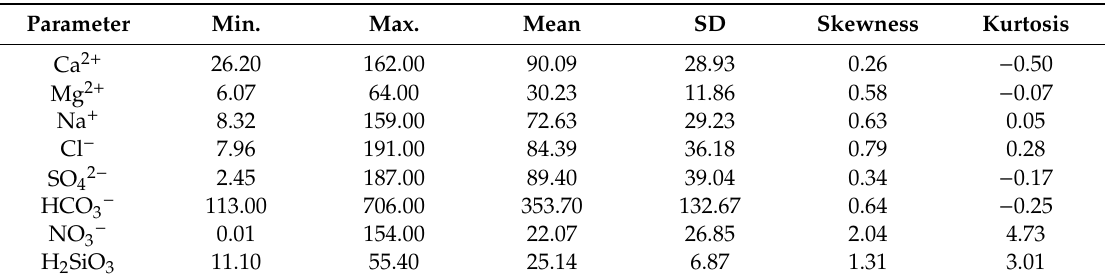
Table 2. Statistical summary of the hydrogeochemical parameters of the shallow groundwater in the Su-Xi-Chang